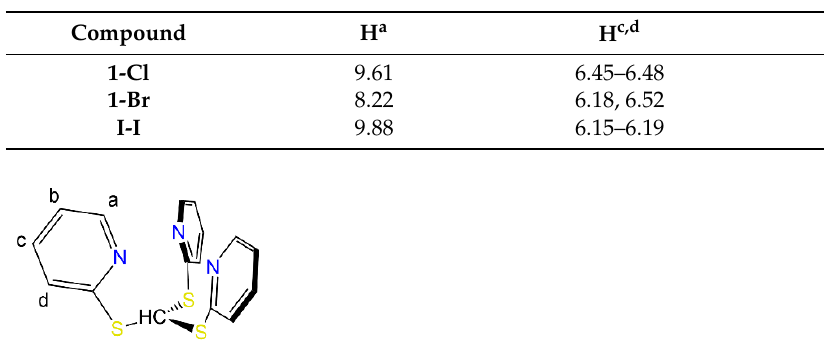
Table 1. 1 H NMR shifts of 1-X .